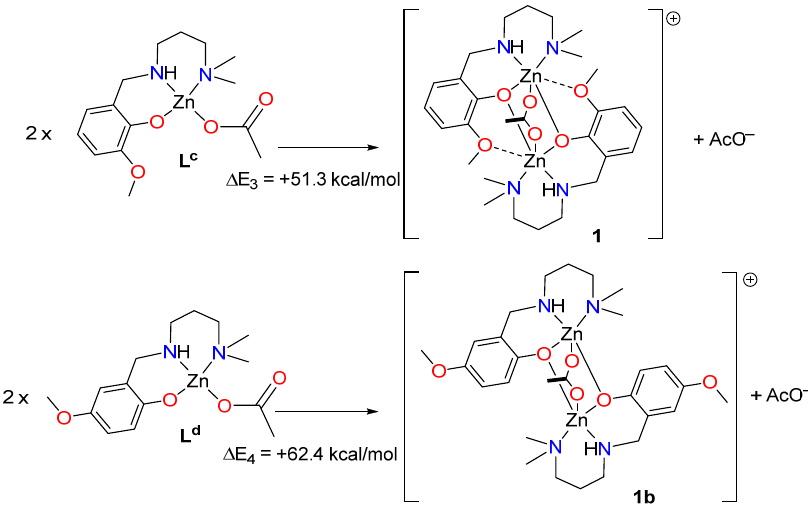
Figure 7. Reactions used to evaluate the spodium bond (SpB) energy in compound 1 .